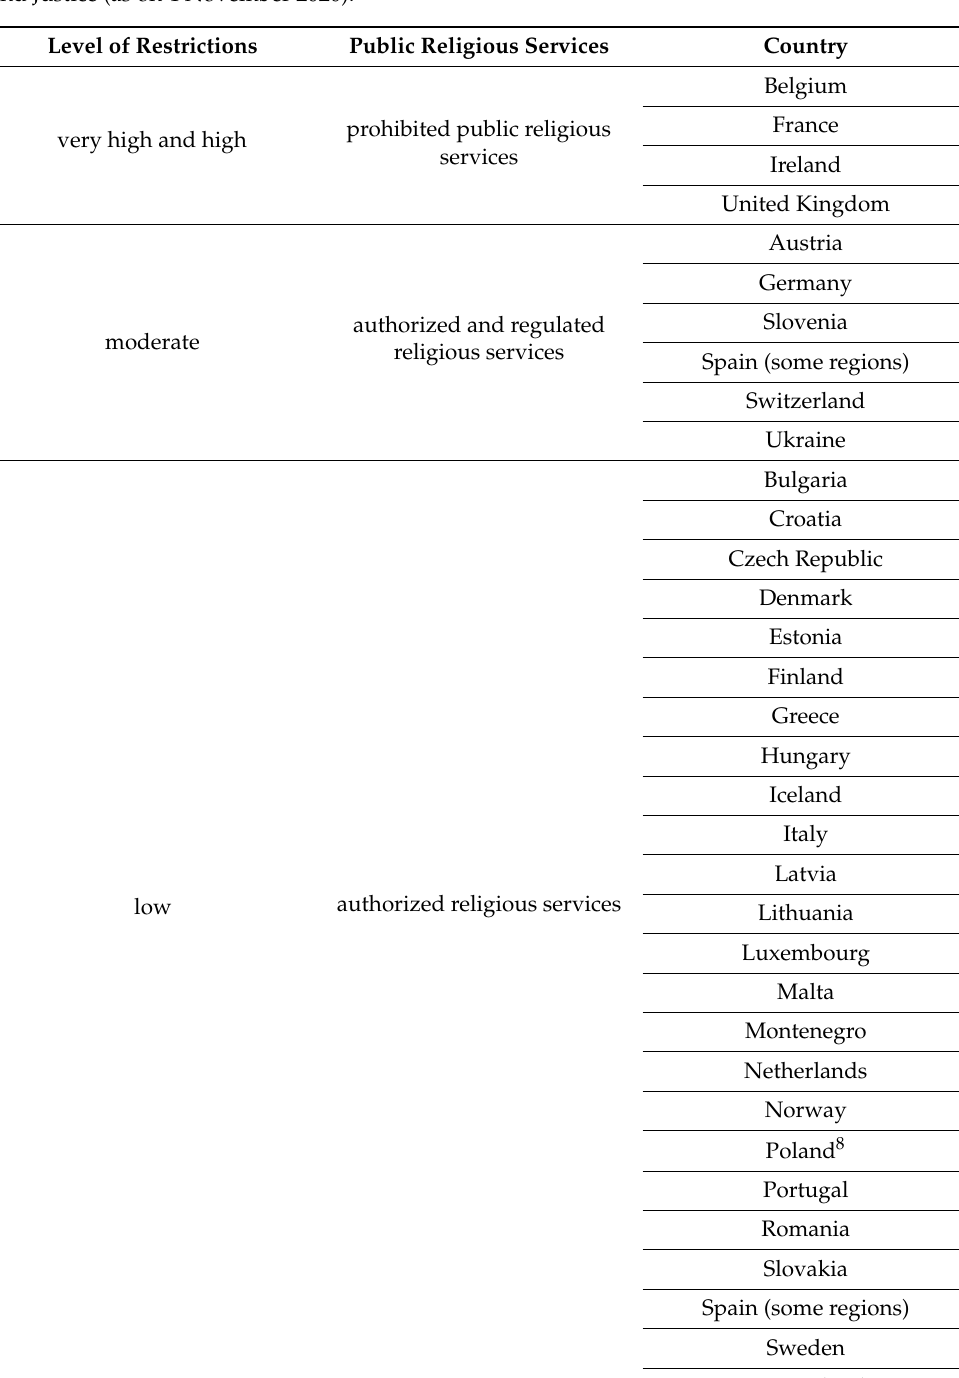
Table 2. The restrictiveness of selected OSCE countries regarding religious freedom due to COVID-19 during the second wave of the pandemic based on data provided by The European Centre for Law and Justice (as on 4 November